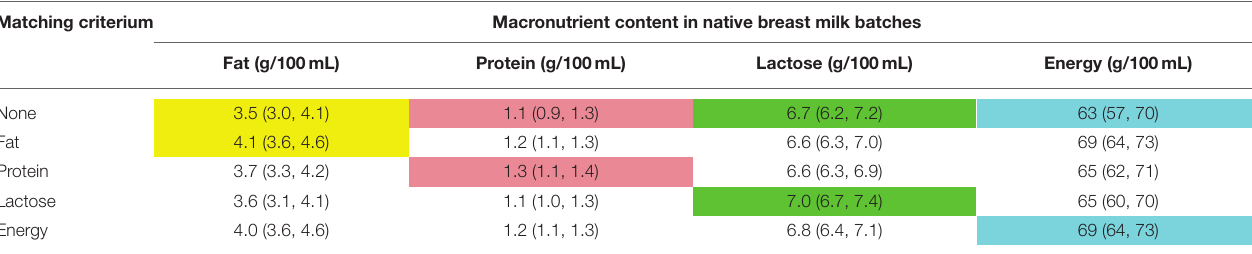
TABLE 6 | Increase of the macronutrient content in native breast milk samples of n = 103 subjects, breast milk samples were selected in groups of 6 or 8 consecutive samples and ordered by either energy, fat, protein, and lactose content. Matching criterium Macronutrient content in native breast milk